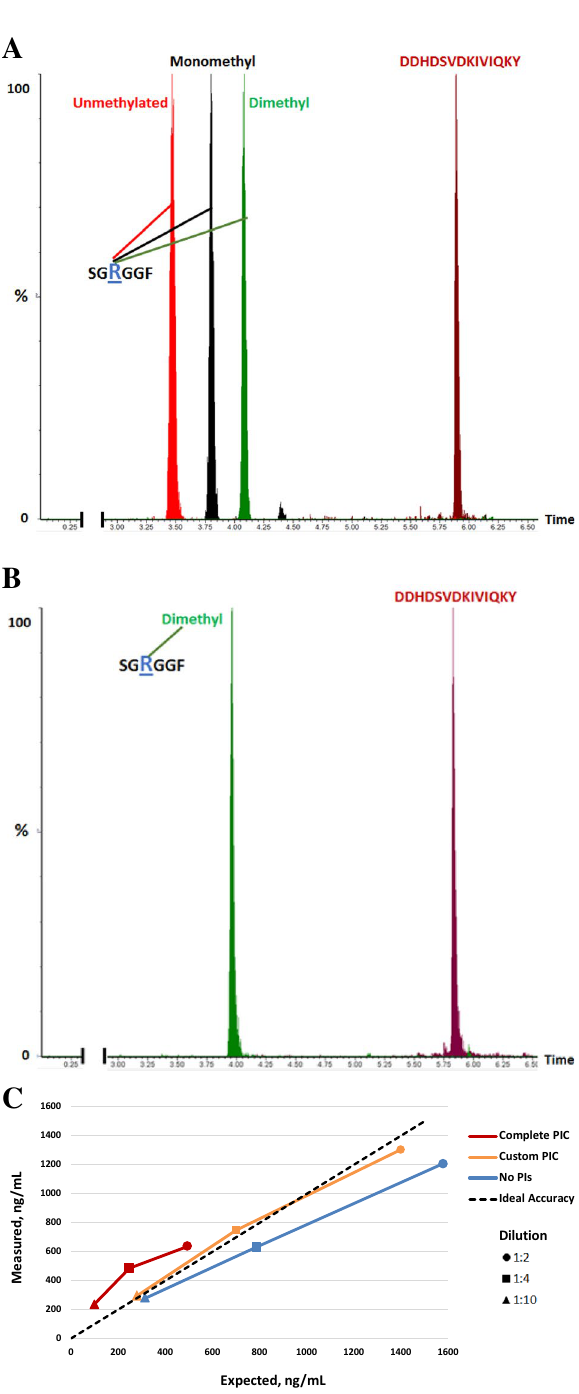
Figure 5. Development of LC–MS/MS method for the detection of hnRNP-A1 in human blood. ( A ) Chromatographic separation of a mixture of synthetic peptides corresponding to hnRNP-A1 223-228 bearing unmethylated, mono-methylated, asymmetrically-dimethylated arginine 225, and the unmodified hnRNP-A1 154-167 peptide. ( B ) Detection of chymotryptically-derived hnRNP-A1 peptides in human PBMC lysates, in which hnRNP-R225 is detected in its dimethylated form. ( C ) Determination of method accuracy for the detection of the DM-R225-hnRNP-A1 peptide employing a complete protease inhibitor cocktail (PIC red horizontal line), a PIC without serine protease inhibitors (yellow horizontal line) or no protease inhibitors (blue horizontal line ) on chymotryptically-digested human PBMC lysates diluted 1:2 (filled circle), 1:4 (filled square) and 1:10 (filled triangle) with PBS. The levels of DM-R225-hnRNP-A1 in undiluted lysates were 988 ng/mL, 3153 ng/mL and 2800 ng/mL in presence of complete PIC, custom PIC and no PIC,